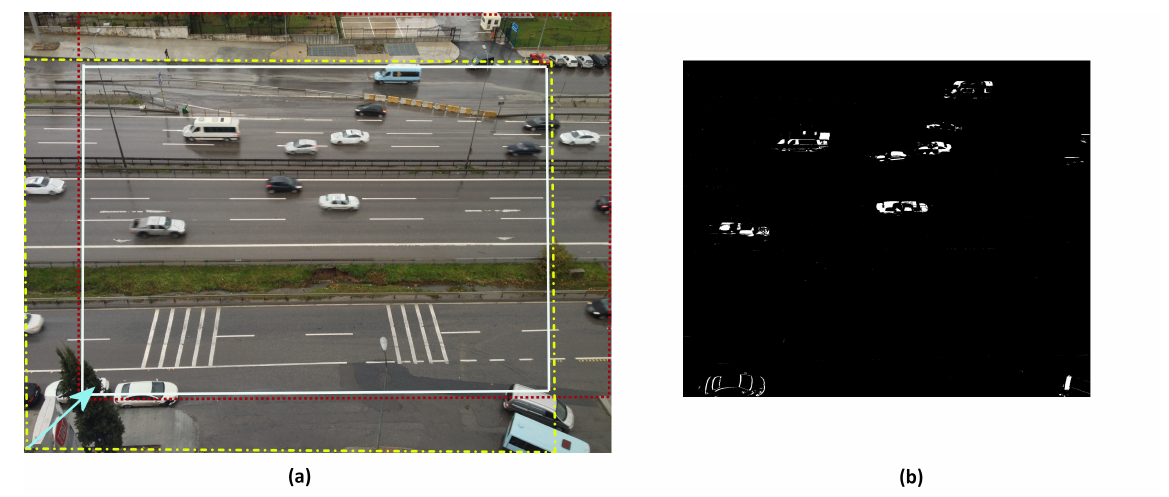
Figure 3. (a). Camera motion estimation (b). Motion